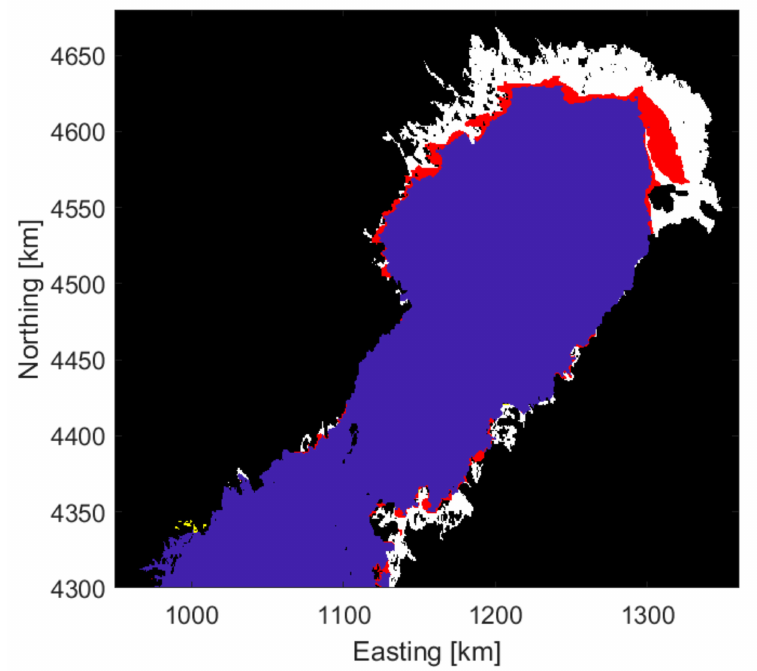
Figure 10. Comparison between the Baltic Sea landfast ice extents on 15 March 2020 from the FIS / SMHI ice chart and the BALFI product. White color show pixels where both products show LFI, red pixels where there is LFI in the BALFI product, but not in the ice chart, and yellow pixels indicate the inverse